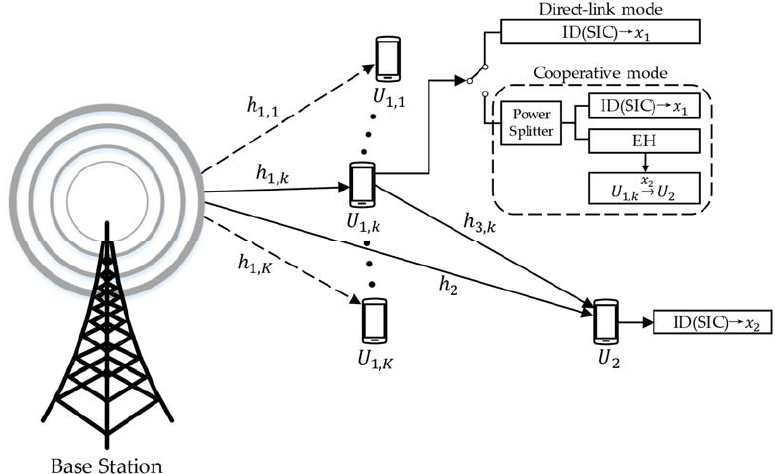
Figure 1. Downlink NOMA–SWIPT cooperative relay network.